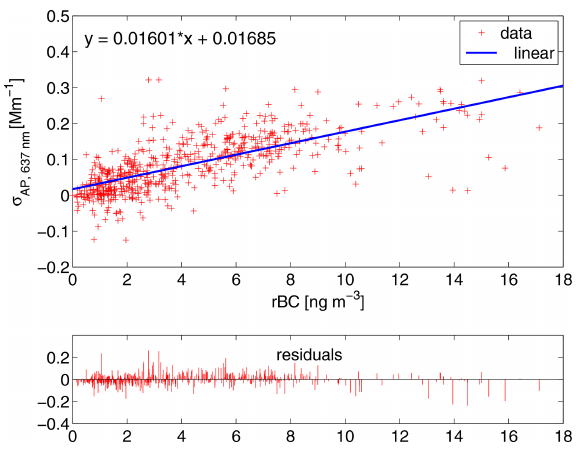
Figure 5. The absorption coefficient measured with MAAP as a function of the rBC concentration measured with SP2. The linear regression slope provides the corresponding mass absorption cross section (MAC = 16 . 0m 2 g − 1 ) value for MAAP, and the lower panel presents the residuals of the